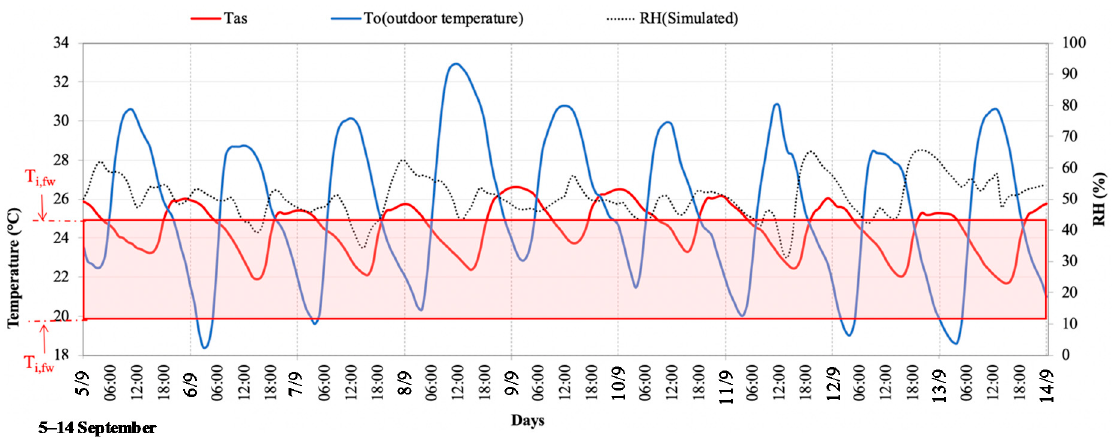
Figure 7. Daily profile of air and operative temperature after retrofit of the building in free-running conditions during 5–14 September. conditions during 5–14